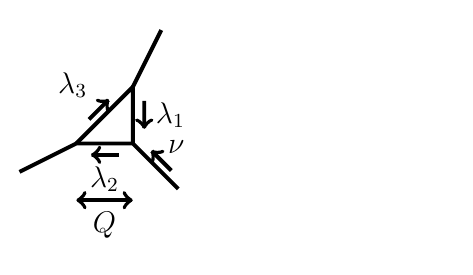
Figure 18 . The assignment of Young diagrams and K(cid:127)ahler parameter for computing the E 0 matter. 5d theory whose web diagram is given in (cid:12)gure 16. A (cid:13)op transition with respect to